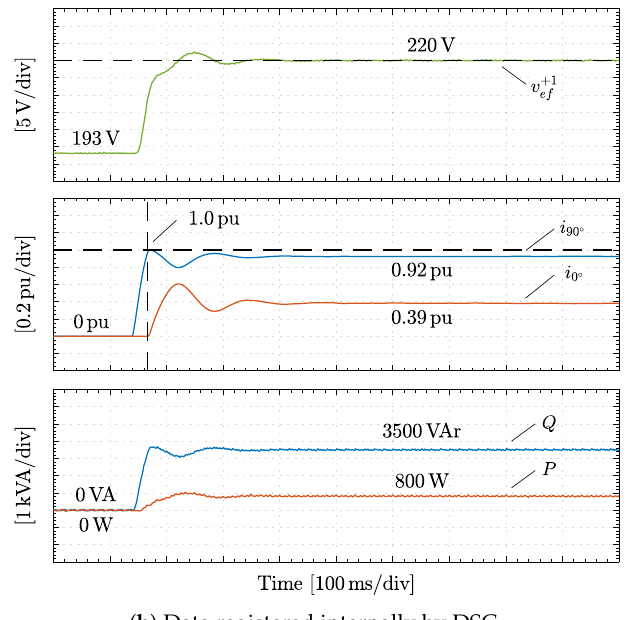
Figure 14. Experimental results: ( a ) Converter currents for voltage regulation with linear loads; ( b ) Results for transient regime: effective voltage, in-phase and quadrature current references and converter injected power. Energies 2020 , xx , 5